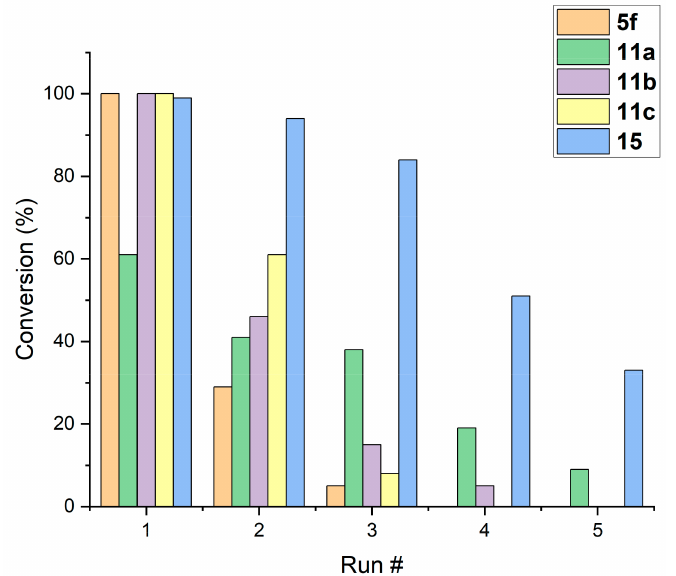
Figure 2. Reusability of catalysts 5f ( ), 11a ( ), 11b ( ), 11c ( ), and 15 ( ) in the model reaction 6a + 7 → 8a . The conversions were determined by 1 H NMR. 2.2. Synthesis and Catalytic Activity of Silica Gel-Bound Cu–Enaminone Complexes 11a–c and 15 Bis-enaminone compounds 9a and 9b [70] (Scheme 3) contain two terminal N,N -(dimethyl)enaminone groups that enable transaminative attachment to 3-aminopropyl silica gel ( 3 ). Thus, treatment of 9a and 9b with 3 in methanol at room temperature afforded the immobilized acacen ligands 10a and 10b , which were subsequently reacted with Cu(OAc) 2 ·H 2 O in methanol to furnish the desired immobilized Cu – acacen complexes 11a and 11b (Scheme 3). To obtain pyridine-type catalyst 11c , bis-enaminone ligand 9c [71], was reacted with 3-aminopropyl silica gel ( 3 ) to give silica gel-bound ligand 10c , followed by treatment with Cu(OAc) 2 ·H 2 O in methanol to furnish the copper complex 11c (Scheme 3). Absorption bands at around 1600 cm − 1 (C = O/C = N) in the IR spectra of compounds 11a–c and the combustion analyses for compounds 11a–c were in line with attachment of copper – enaminone complexes to 3 (For characterization details see the Supporting Information).